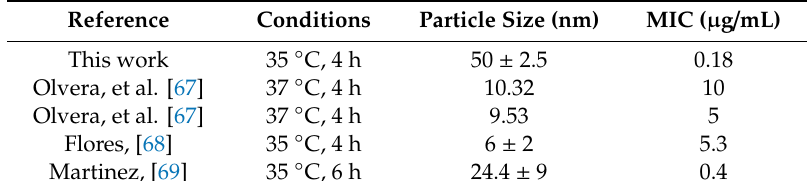
Table 3. Comparison of the inhibitory e ff ects of AgNPs against P. aeruginosa cultures found by di ff erent authors.